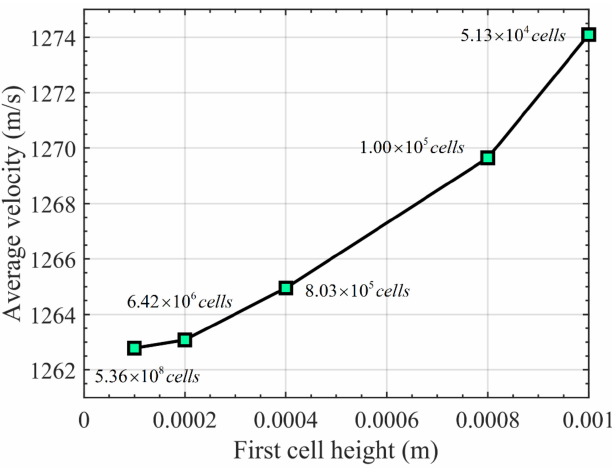
Figure 8. Verification of grid independence for the